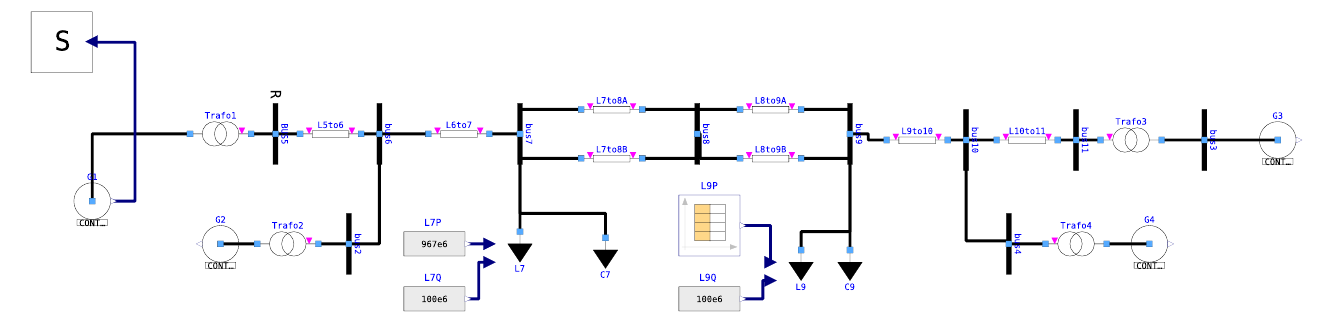
Figure 4. Two-area-system model from [22] implemented using PowerGrids in OpenModelica.